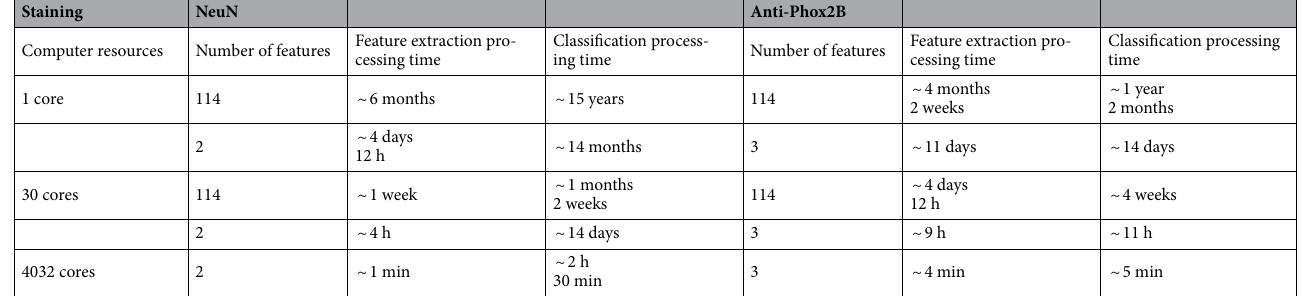
Table 7. Computation times for feature extraction and classification steps for a whole brain stained with NeuN_1 and a whole brainstem stained with anti-Phox2B. The duration times were effectively measured with a 4,032-cores-supercomputer and theoretically estimated for the others.